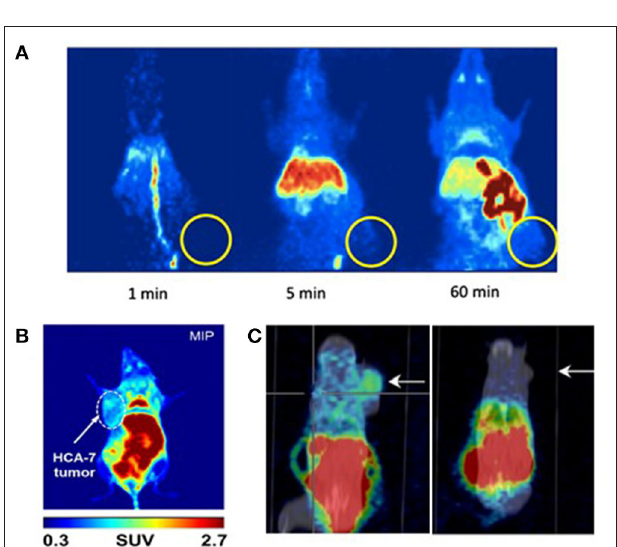
FIGURE 9 | Radiosynthesis of indomethacin derivative 124 I-12.